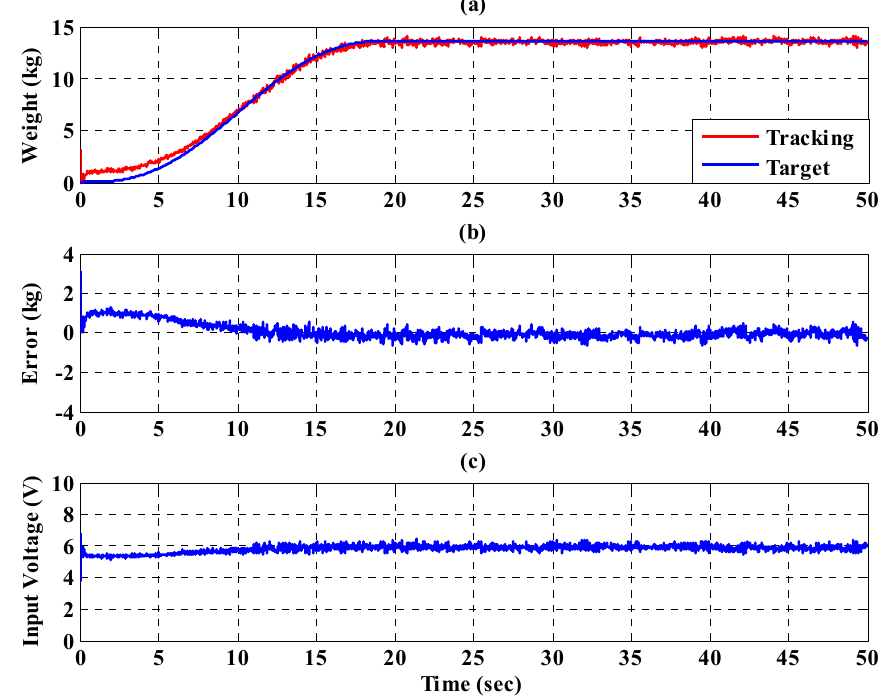
Figure 20. Experimental results for the PBWSS with a static bodyweight unloading force of 20% (13.6 kg) in 50 s. ( a ) Tracking trajectory; ( b ) tracking error; ( c ) control voltage.